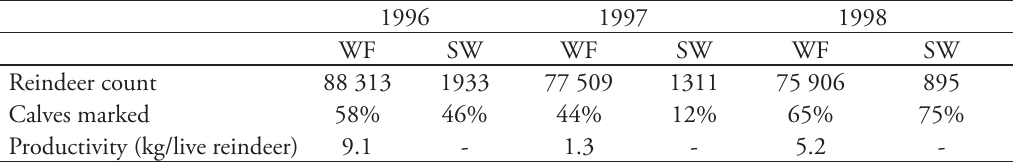
Table 2. Number of reindeer ( Rangifer t. tarandus ), percentage of calves marked and productivity for West- Finnmark herding region (WF) and Seiland West herding area (SW) in 1996, 1997, and 1998.